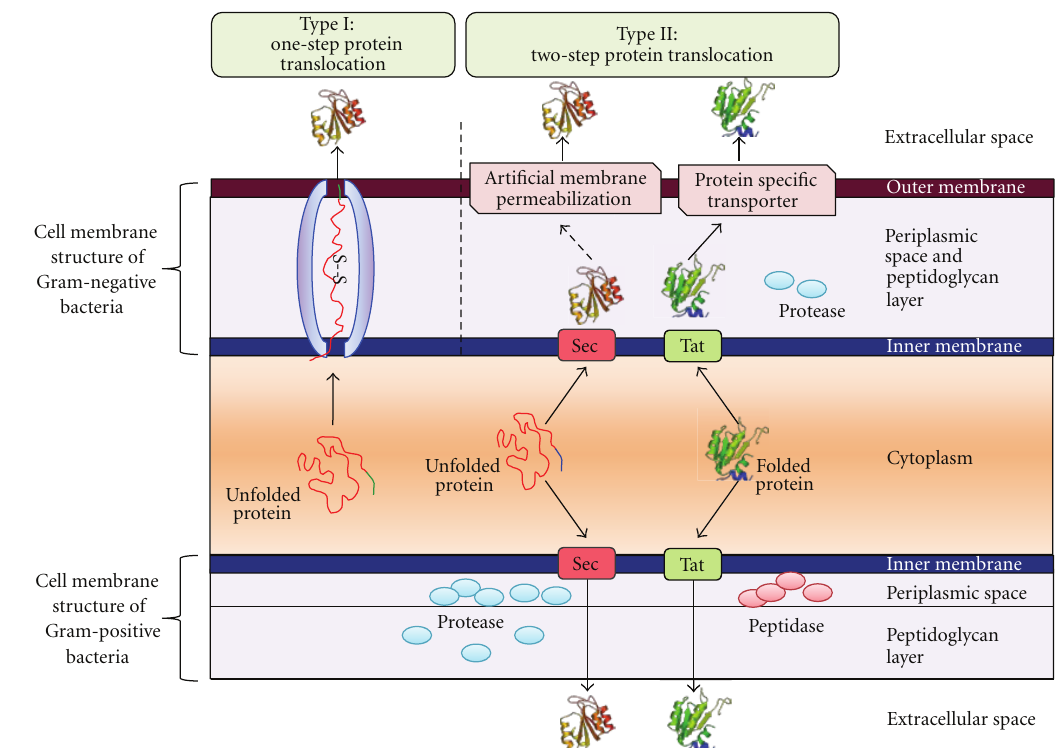
Figure 1: Outline of the major di ff erence between the protein secretion system of Gram-positive and Gram-negative bacteria. Presence of thick outer membrane in Gram-negative bacteria demands for outer membrane permeabilization through the addition of mild detergent, lpp deletion, or by fusing the recombination protein with kill or out